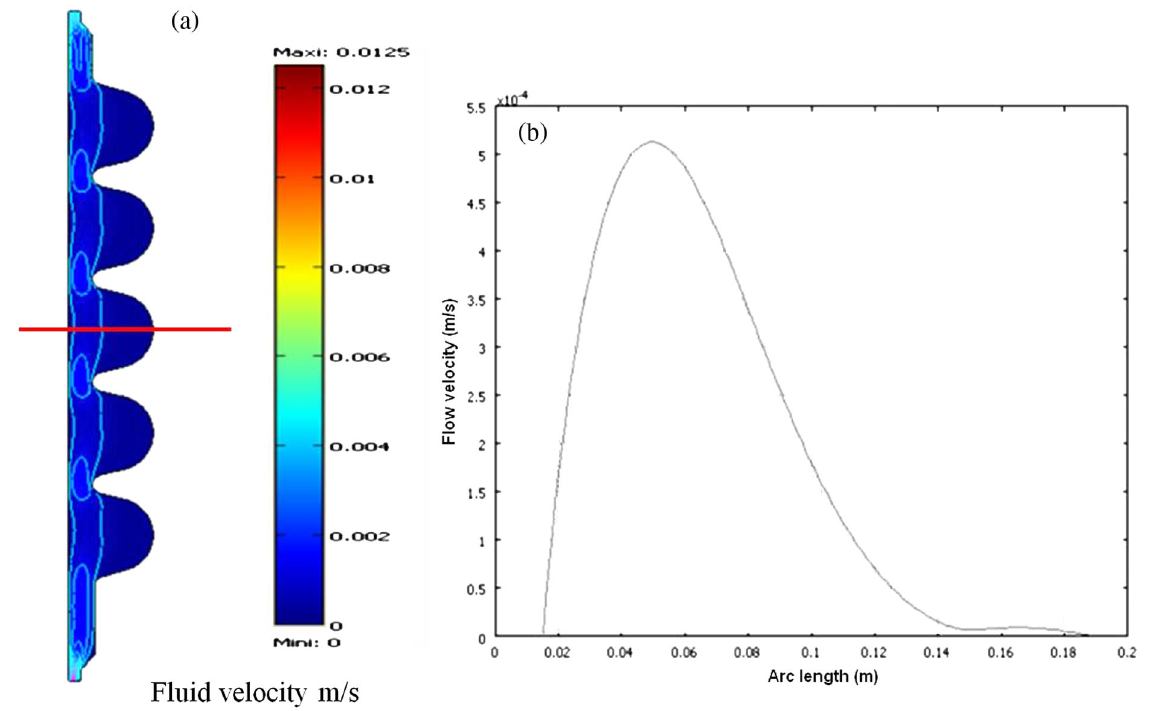
FIG. 9. (a) Fluid distribution in the five-cell SPL cavity and (b) fluid velocity profile along the red line.